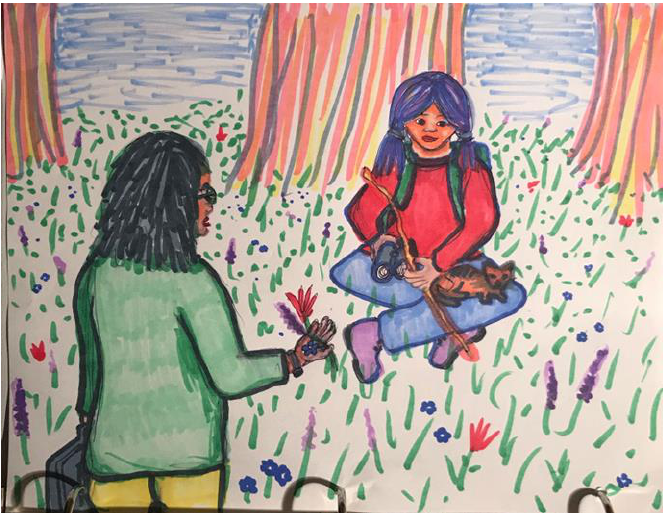
Figure 4. A mother-daughter dyad explore differing gender identities through